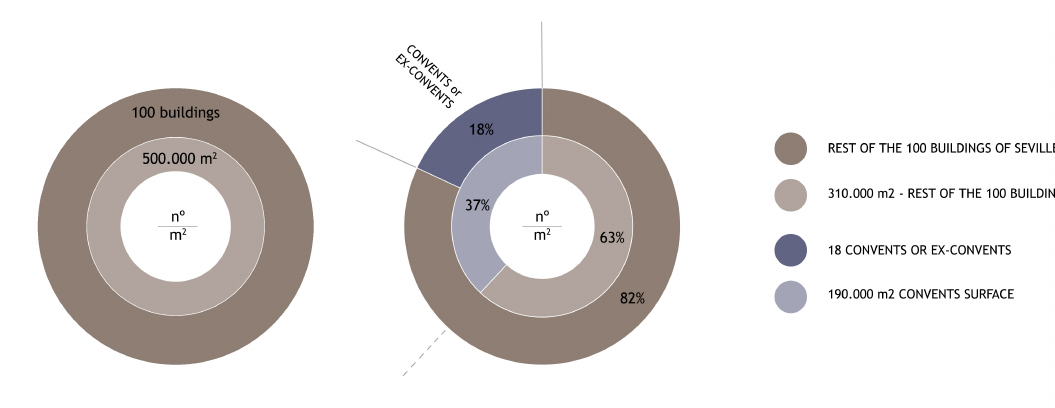
Figure 2: Eighteen convents or ex-convents in the one hundred buildings.